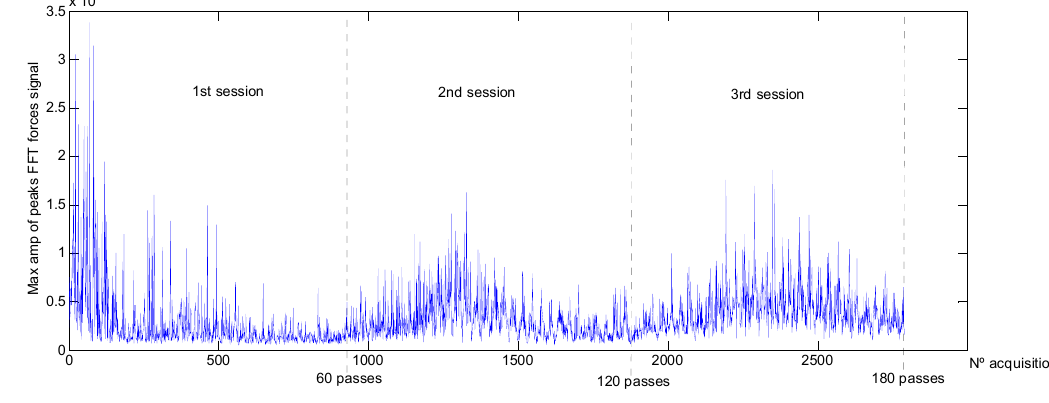
Figure 7. Maximum amplitudes of FFT power spectral of forces signal (100–1000 Hz).